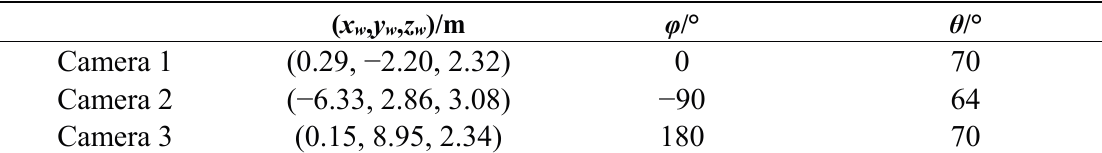
Table 2. Geometrical parameters of